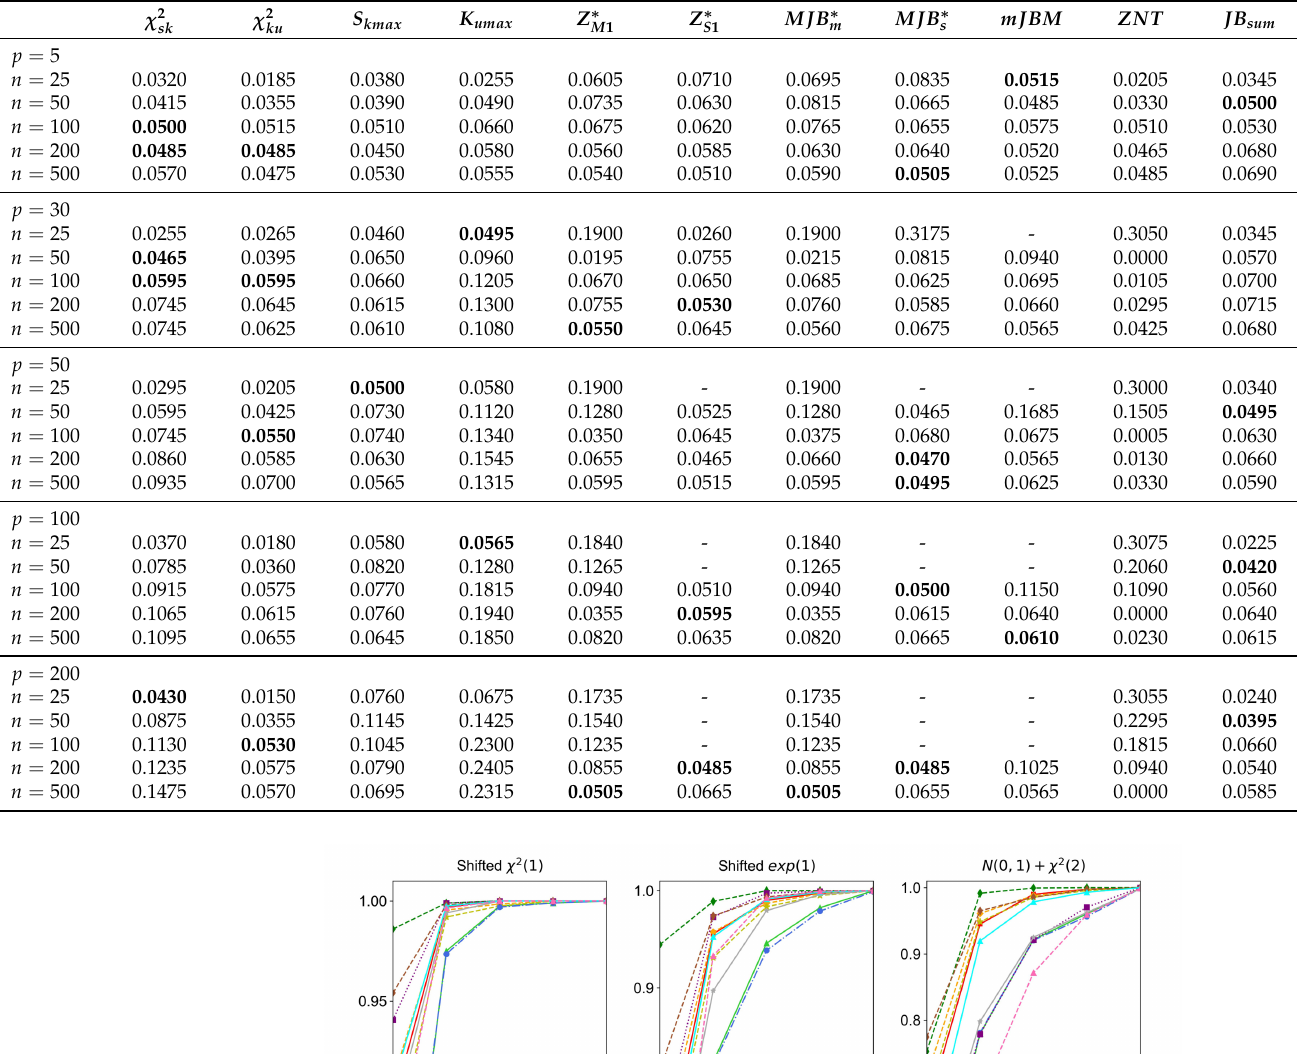
Table 2. Empirical power of PC-type Jarque–Bera (JB) testing for normally distributed data for Case-I compared with other methods ( α = 0.05).